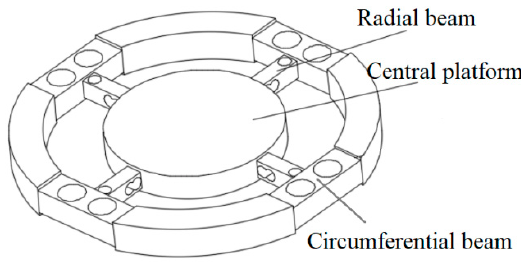
Figure 2. A novel elastomer type of six-axis force sensor.